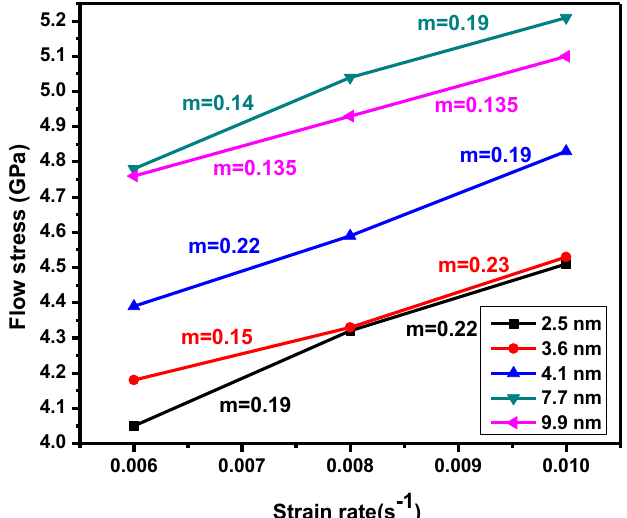
Figure 4. Flow stress as a function of strain rate for NC 316 L stainless-steel, with various mean grain sizes.